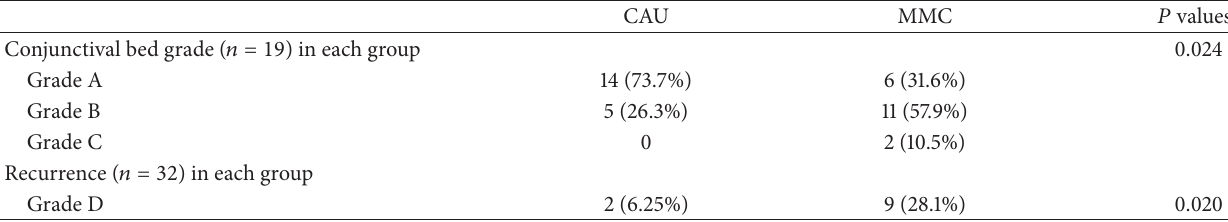
Table 4: Comparison of Conjunctival Bed Grading in Conjunctival Autograft and Mitomycin C Groups. CAU MMC 𝑃 values a Conjunctival bed grade ( 𝑛 = 19 ) in each